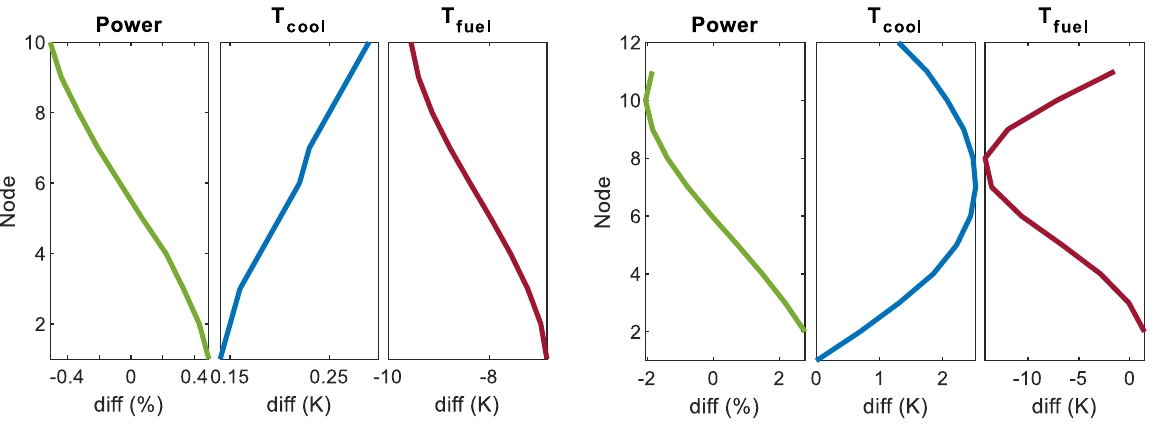
-p )/p ] and the absolute nTF/CTF nTF/1D-TH nTF/CTF -T ] for a small of 2m height and a VVER-440 nTF/CTF nTF/1D-TH assembly of 2.5m active height and axial